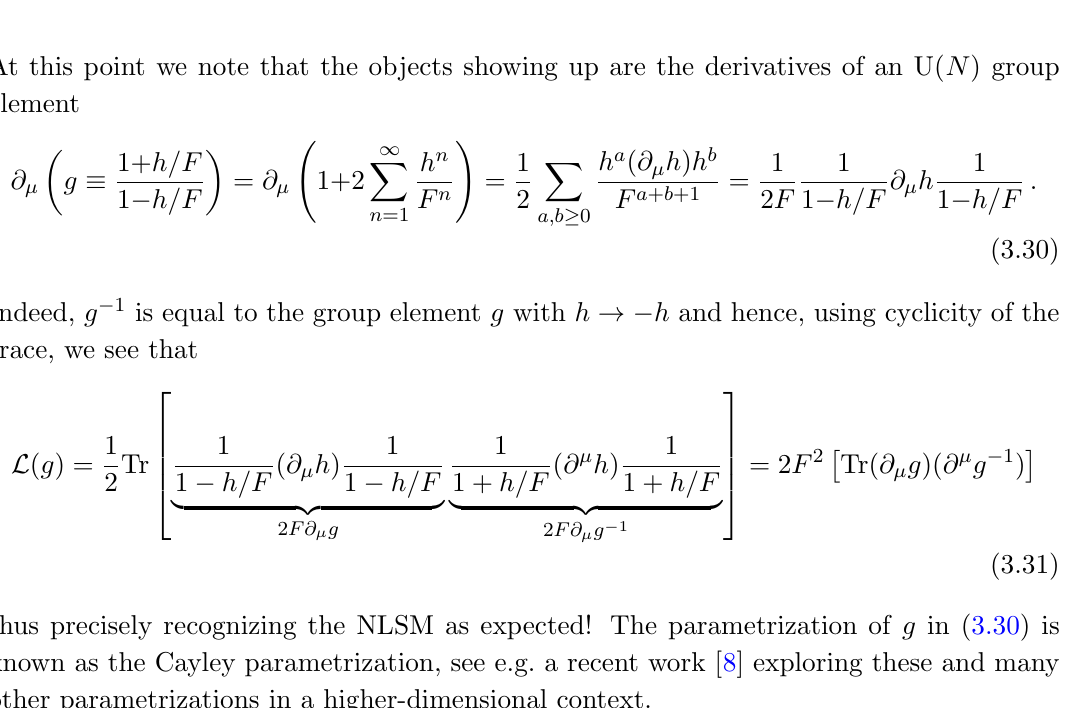
Figure 6 . As done for the case with no derivative interactions, one groups the Feynman diagrams contributing to this amplitude by the vertex containing p 1 . The sum of diagrams in the group corresponding to an m -particle vertex is proportional, to leading order, to a full ( n m +2)-particle (cid:0) amplitude and vanishes for m < n 2. The propagator can be treated as an on-shell right moving (cid:0) particle because its left-moving part is of order y m= 2 (cid:0) 1 and is vanishingly small in comparison to any left-moving momenta to the left of the